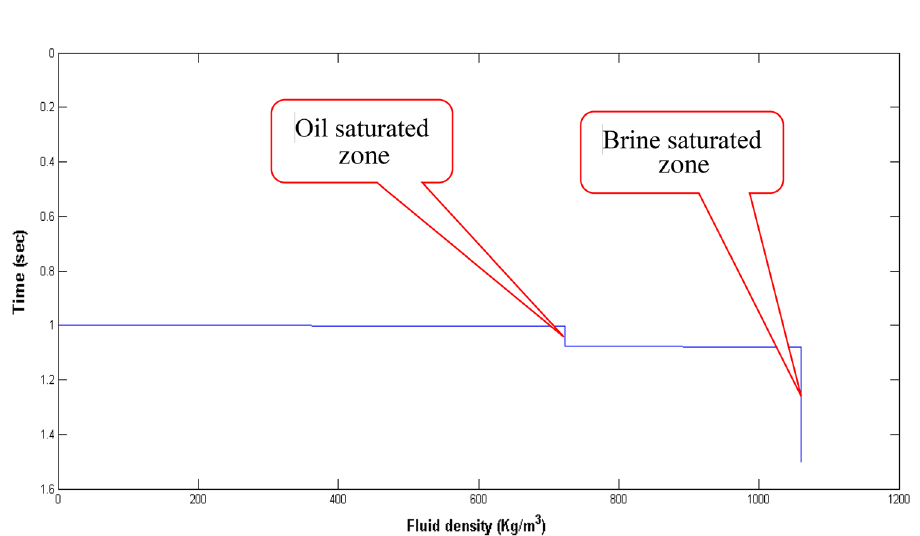
Fig. 9 Fluid density plot of case 2